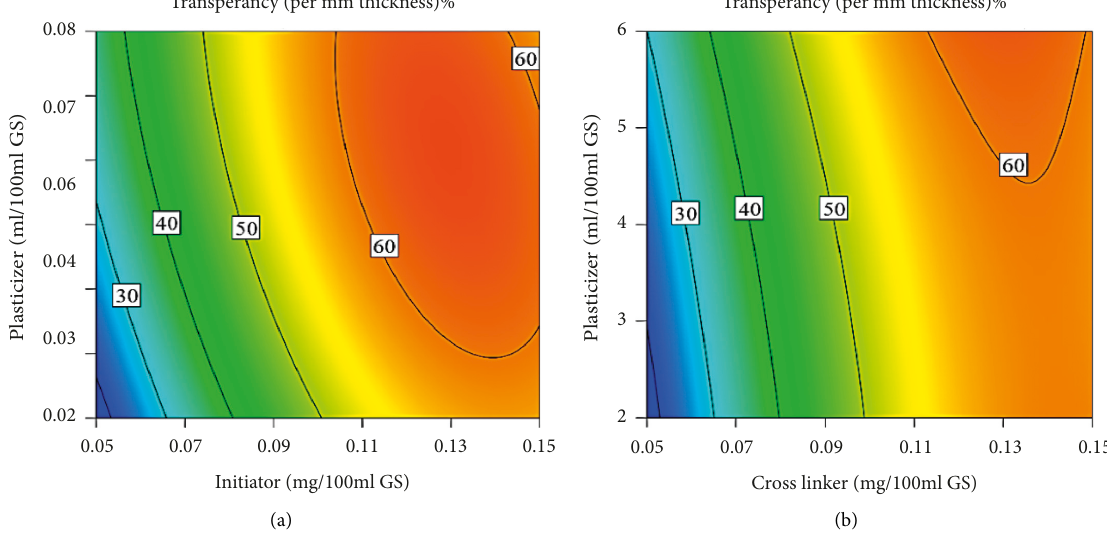
Figure 5: (a) Combined effects of initiator and crosslinker on transparency at the optimum value of plasticizer concentration (2.88mL/ 100mL GS). (b) Combined effects of initiator and plasticizer concentration on transparency at the optimum value of crosslinker (0.02 mg/ 100mL